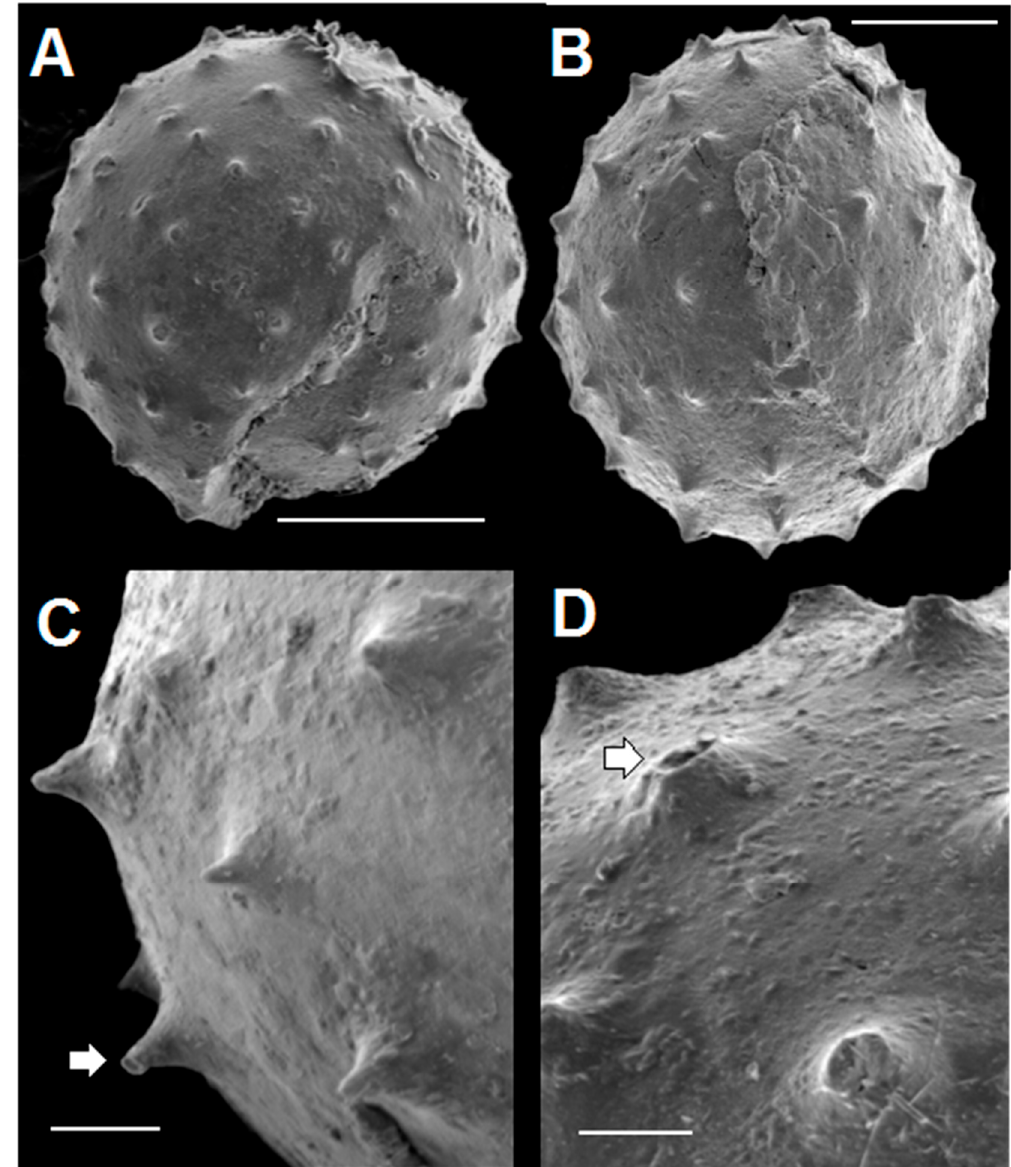
Figure 8. SEM images of pyritized spinose, acanthomorphic specimens extracted from rock matrix. Scale bar in A = 40 µm. Scale bar in B = 25 µm. Scale bar in C, D = 10 µm. ( A ) spheroidal specimen (TYS-29) with large crack showing arrangement of spines; ( B ) ovoid specimen (TYS-38) with spines; ( C , D ) Detail of spines in two specimens. White arrows point to flat-topped spines that have hollow interiors. C: TYS-32. D: TYS-41.